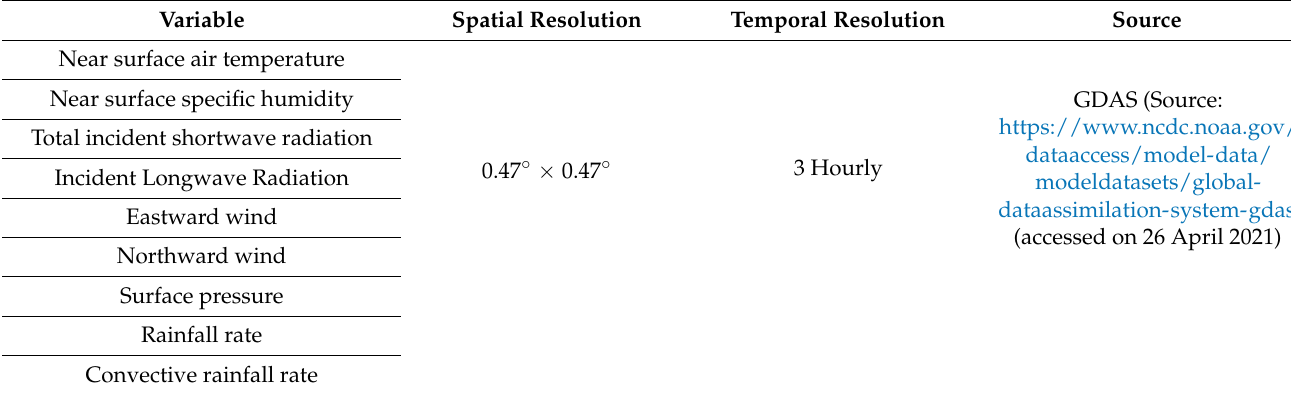
Table 1. Specification of forcing variables used for Noah LSM.